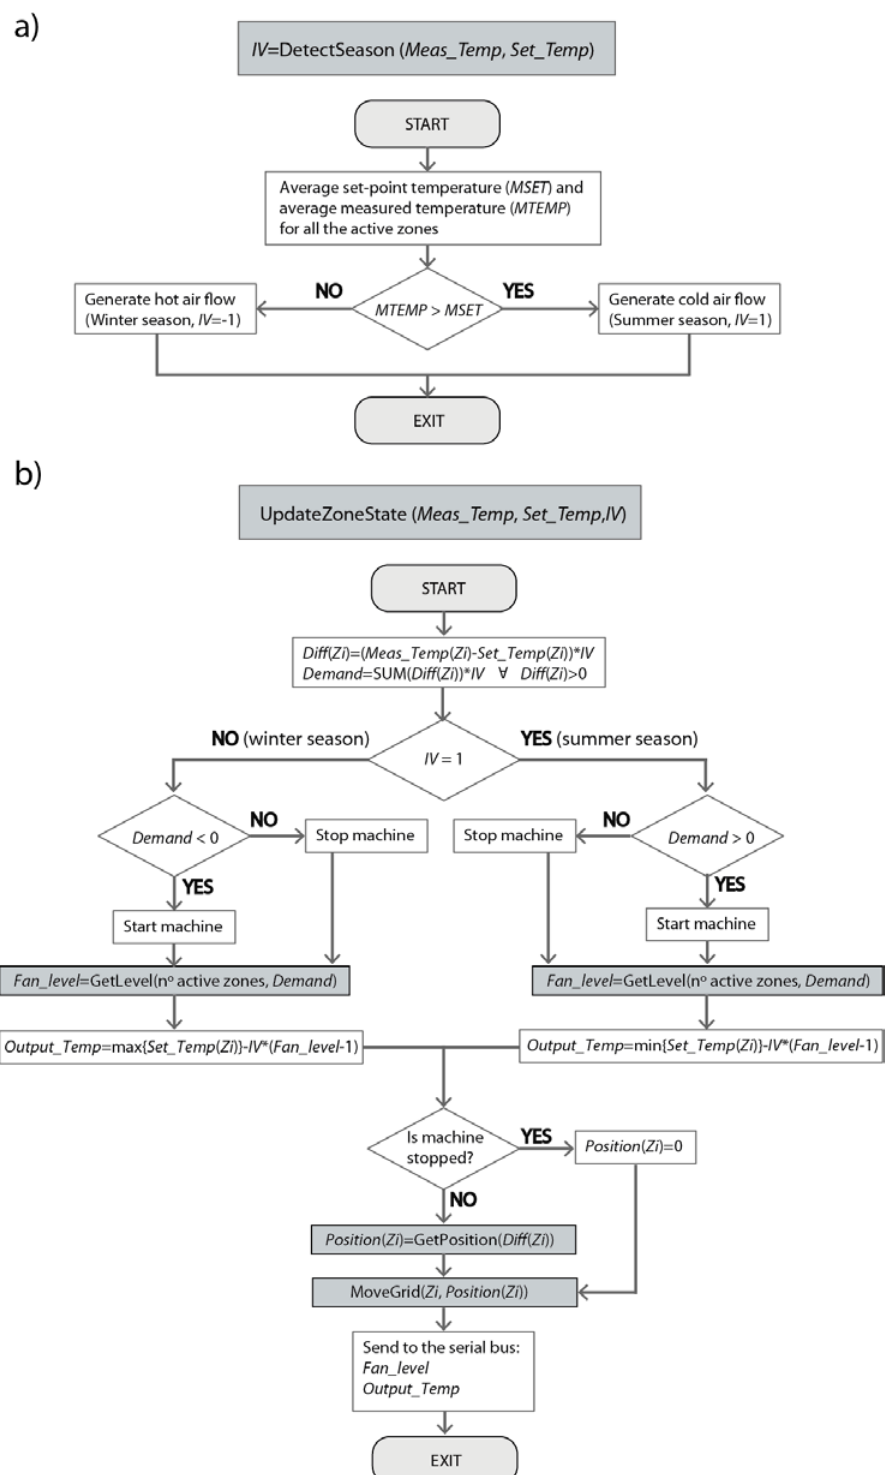
Figure 9. ( a ) Flowchart of the DetectSeason function; ( b ) flowchart of the UpdateZoneState function. According to the specifications of Mitsubishi machines, three possible fan velocities (low, middle Initially, the differences between the measured and the set-point temperatures are obtained for and high) are assigned, based on the absolute value of the Demand variable and the number of active each of the active zones and multiplied by the variable IV, Diff(Zi). Thus, a positive value of Diff(Zi) zones (see Table 2). In the case of only one active zone, the fan velocity is set to the lowest level indicates that the desired temperature has not been reached in this zone yet. The sum of all the regardless of the value of the Demand variable. This avoids possible overpressures in the motor positive Diff(Zi) values multiplied by the variable IV is saved in the variable Demand. Negative Demand values correspond to the winter season, so the air conditioning system generates heat. In